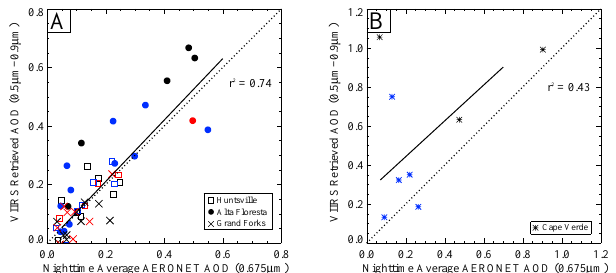
Figure 6. VIIRS-retrieved τ as a function of straddling daytime- averaged AERONET τ for Huntsville (left, Fig. 6a, square), Alta Floresta (left, Fig. 6a, circle), Grand Forks (left, Fig. 6a, “x”), and Cape Verde (right, Fig. 6b, asterisk). One-to-one (dotted) and best- fit (solid) lines are also shown. Cape Verde is isolated due to its relative small size (6 pixels). Retrievals made on nights with a lunar fraction less than 15% or with a lunar zenith angle greater than 89 ◦ (below the horizon) are shown in black. Retrievals made on nights with a lunar fraction greater than 15% but less than 50% and a lunar zenith angle less than 89 ◦ are shown in red. Retrievals made on nights with a lunar fraction greater than 50% and a lunar zenith angle less than 89 ◦ are shown in